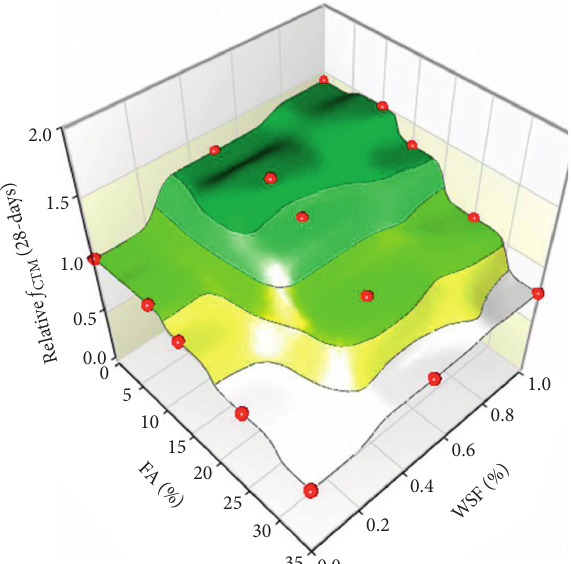
Figure 13: Relationship between WSF and FA contents and relative f CTM .